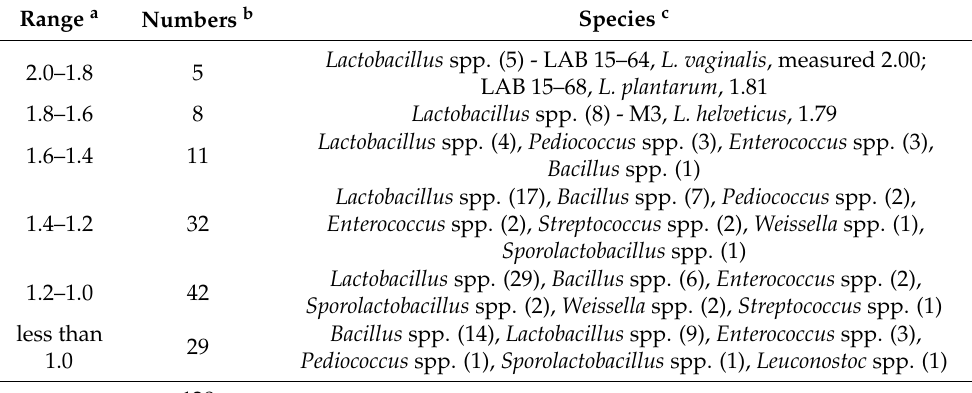
Table 1. In vitro inhibitory effect of LAB against